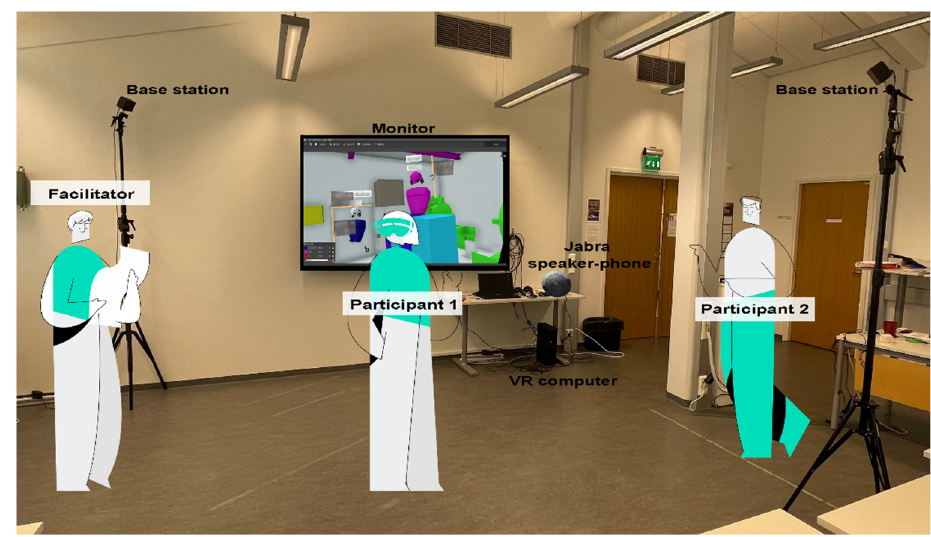
Figure 10. The physical setup of each testing site in Case 4. The base stations were only needed with HTC Vive, not with With Oculus Rift S.